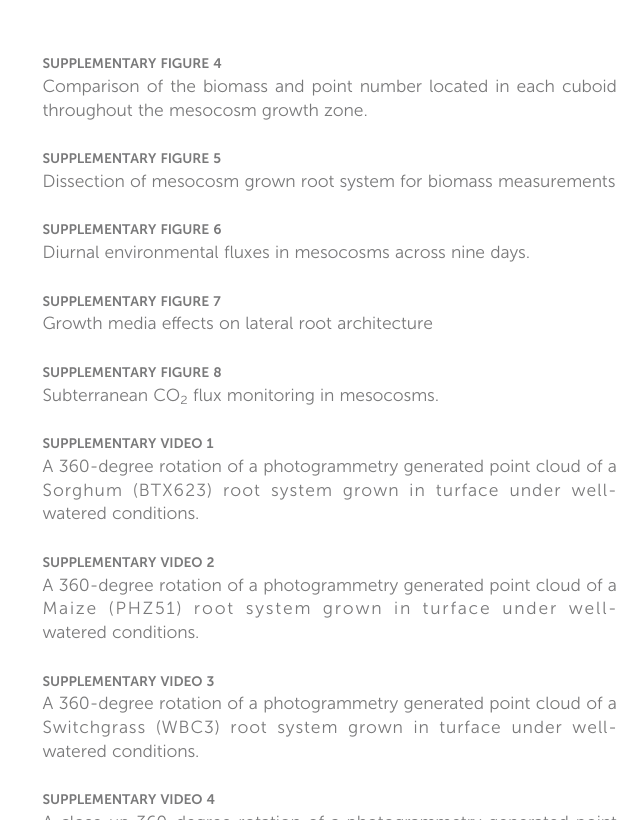
SUPPLEMENTARY FIGURE 1 Interpolation of 3-dimensional environmental sensor data.